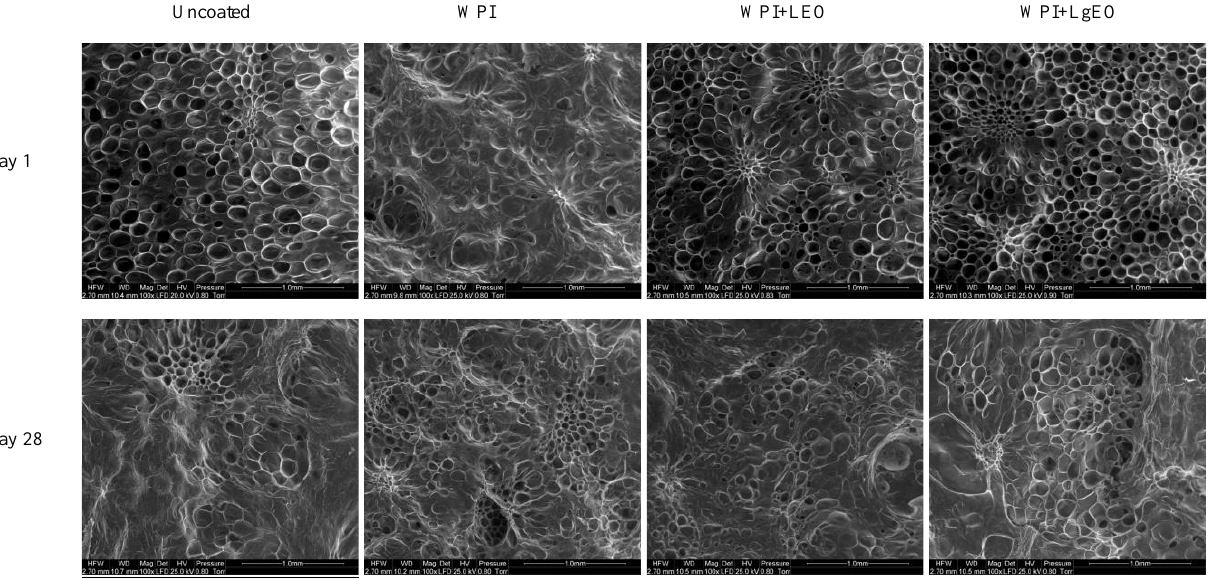
Figure 8. Scanning electron micrographs of fresh-cut pears coated with whey protein isolate coatings (WPI) incorporated with lemon (WPI + LEO) and lemongrass (WPI + LgEO) essential oils or uncoated (Magnification 100×).